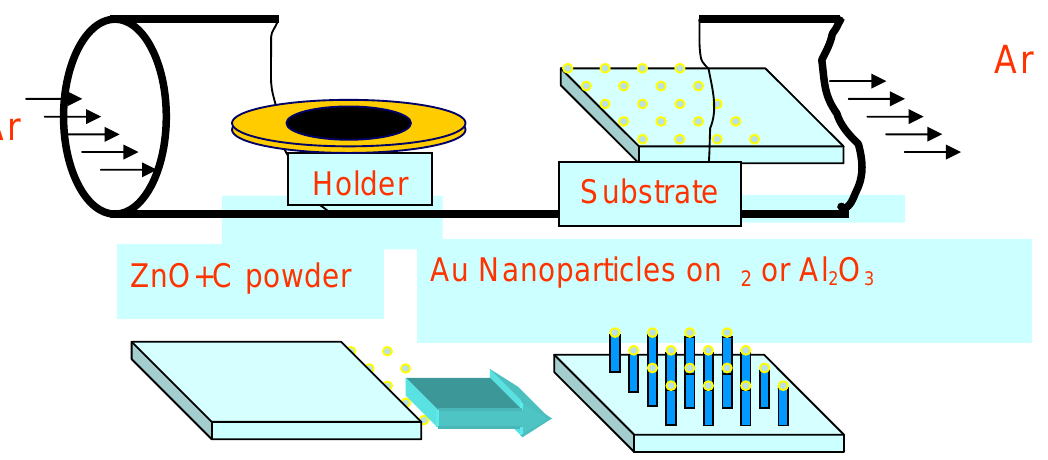
liquid solid growth of ZnO